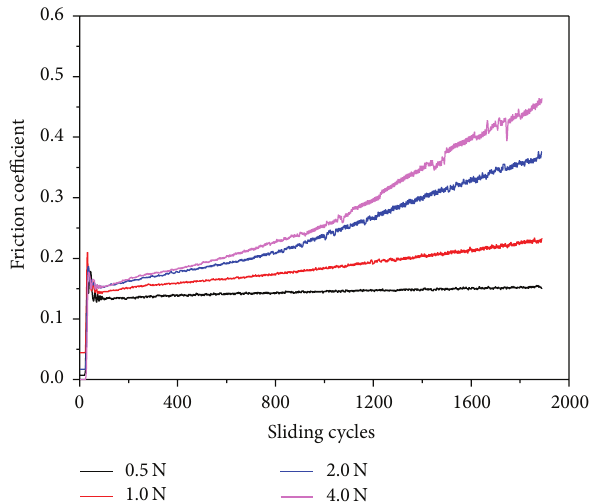
Figure 4: Friction coefficient of Ni-Ti coating after the heat treatment slidingagainst SAE52100 steel ballsasa function ofsliding cycles.